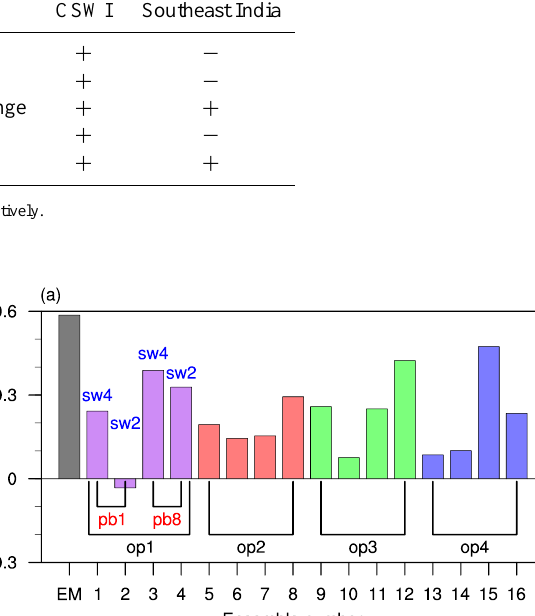
Table 3. Rainfall response in various regions of India to Middle East dust in this study and others. Reference